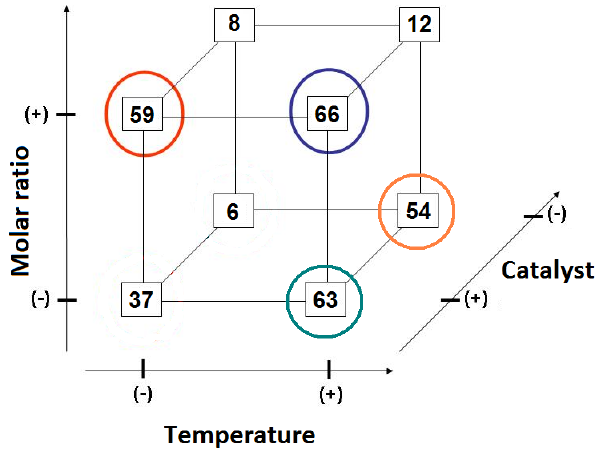
Figure 9. Geometric representation of 2 3 factorial planning, with emphasis on best conversion rates.